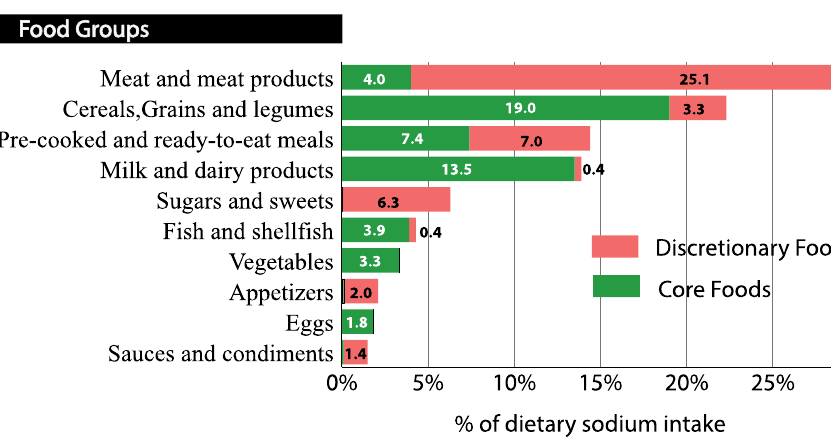
Figure 2. Sources of dietary sodium based on their classification as core or discretionary foods ( n